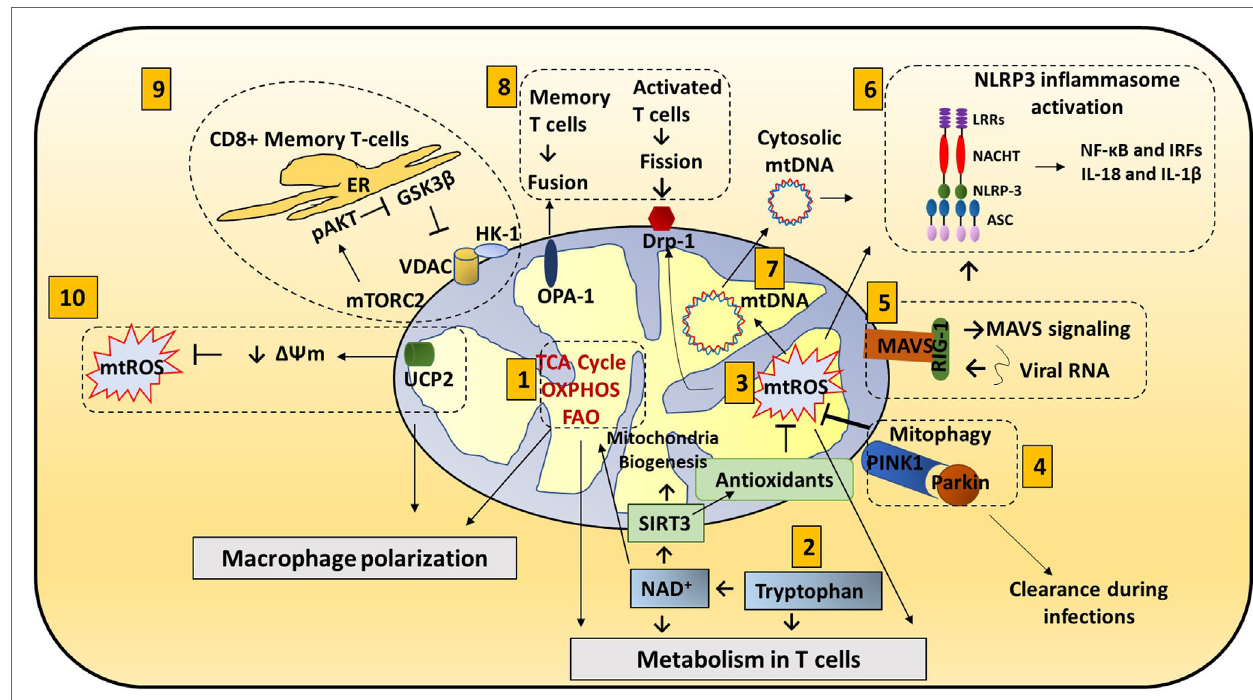
FiguRe 1 | Mitochondria roles in immune responses: mitochondrial components are involved in immune functions. (1) Metabolic pathways such as TCA cycle, oxidative phosphorylation (OXPHOS), and fatty acid oxidation (FAO) are important for macrophage polarization and T cell differentiation. (2) Amino acid metabolism (Tryptophan metabolism is shown here.) also contributes to mitochondrial immune functions. Tryptophan depletion can cause immune tolerance. NAD + is synthesized from tryptophan. NAD + contributes to SIRT3-mediated mitochondrial biogenesis. In addition, NAD + is required for metabolic pathways and CD4 + T cell differentiation. (3) Mitochondrial ROS ( mtROS ) control immune cell transcription, metabolism, and NLRP3 mediated inflammation. Antioxidants such as glutathione balance mtROS. SIRT3 is involved in regulating many mitochondrial proteins such as IDH2 (TCA cycle), MnSOD [reactive oxygen species (ROS) balance], and FOXO3. SIRT3 inhibits mtROS. (4) Mitophagy is crucial for removing damaged mitochondria. Damaged mitochondria are a source of mtROS so mitophagy balances mtROS. Pink1, localized on the mitochondrial outer membrane, binds to parkin and initiates mitophagy. Parkin mutations can increase the susceptibility to